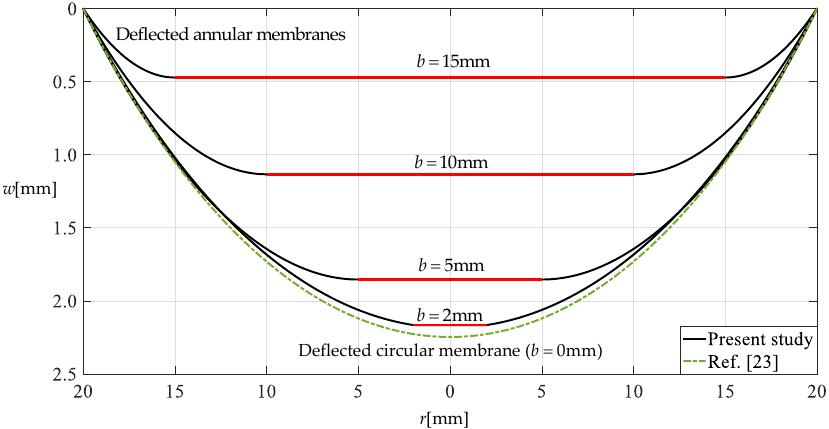
Figure 11. The deflection profiles of the annular membranes gradually approaching that of the circular membrane as inner radius b decreases from 15 to 2.